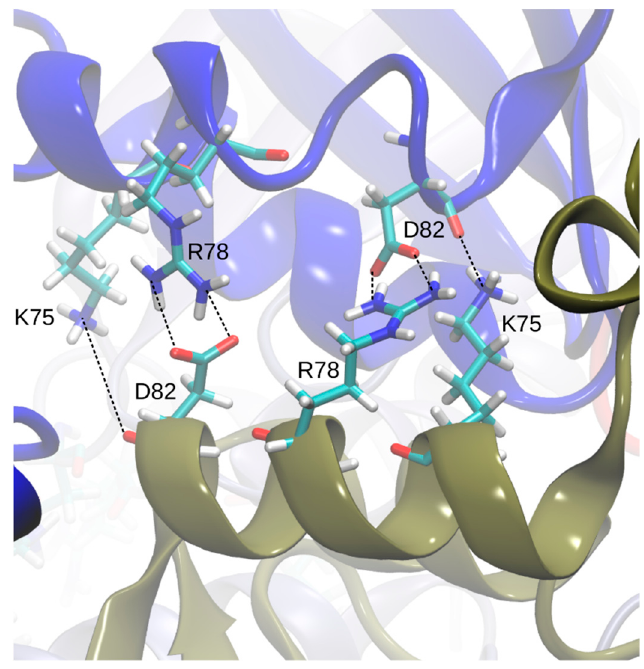
Figure 5. Inter-trimer interactions. Residues Lys75, Arg78, and Asp82 (in one-letter code) on helix α 4 (blue), and their symmetry-equivalent residues on antiparallel helix α 4’ from the closest subunit on the other trimer (tan), are shown as stick models in atomic colors with cyan carbons. Dashed lines show all hydrogen-bonded salt bridges that form during the simulation, although not all are within hydrogen-bonding distance simultaneously (as shown in Figure 6); e.g., in this snapshot taken from 1903 ns, the distance between the left-most Lys75–Asp82 pair is longer than hydrogen-bonding distance.